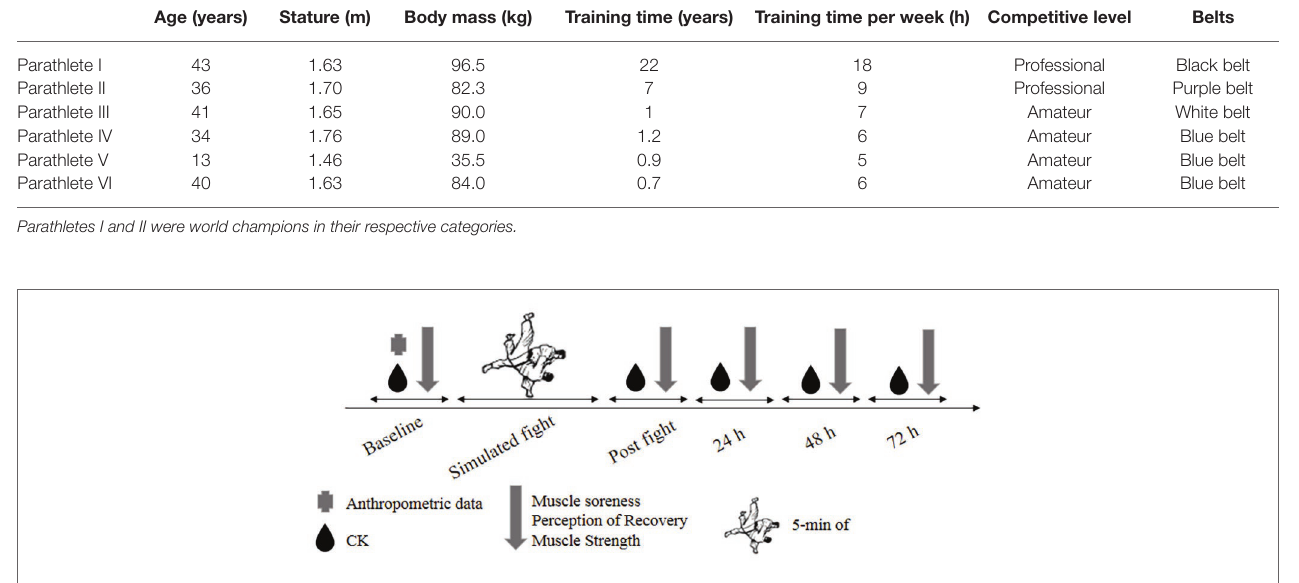
FIGURE 1 | Design study. CK, creatine kinase; 5-min of, five minutes of simulated